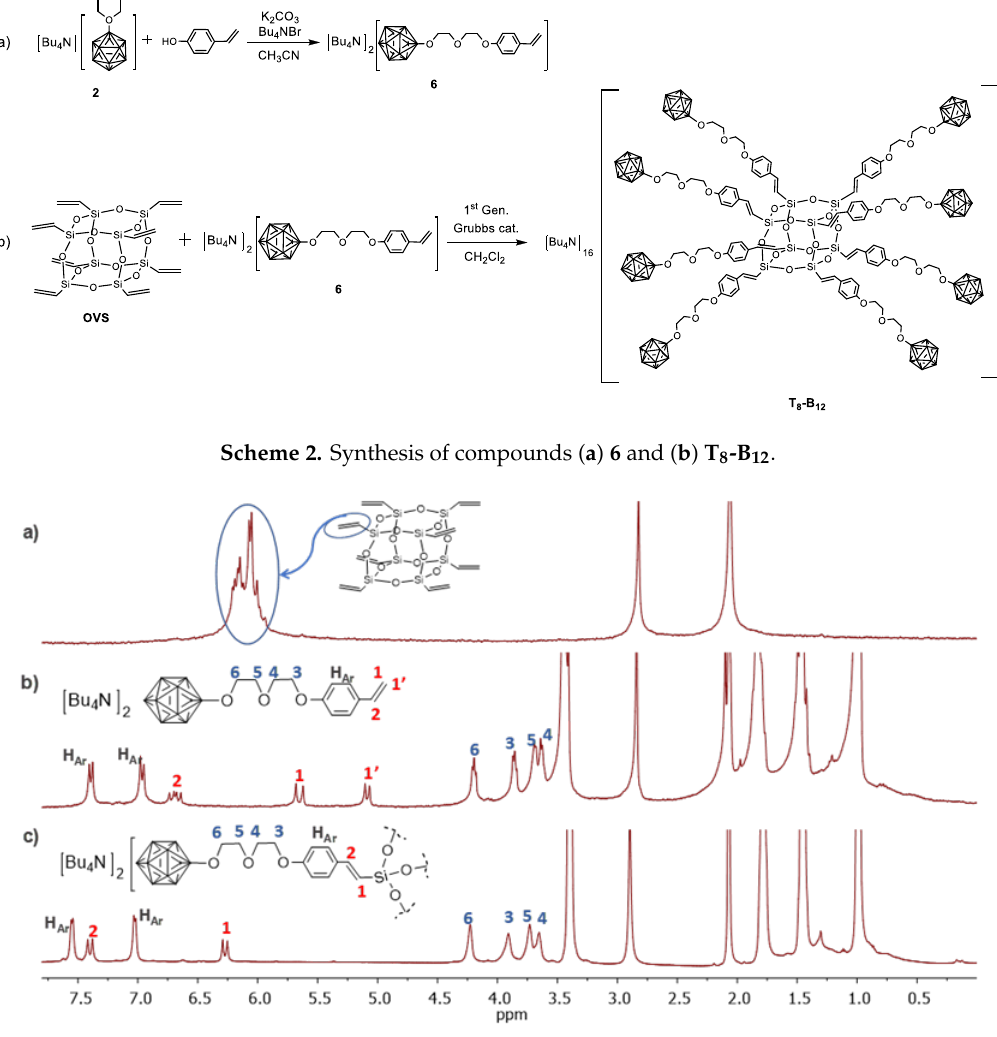
Figure 1. 1 H-NMR spectra in acetone-d 6 of ( a ) octavinylsilsesquioxane (OVS), ( b ) compound 6 and ( c ) T 8 -B 12 .